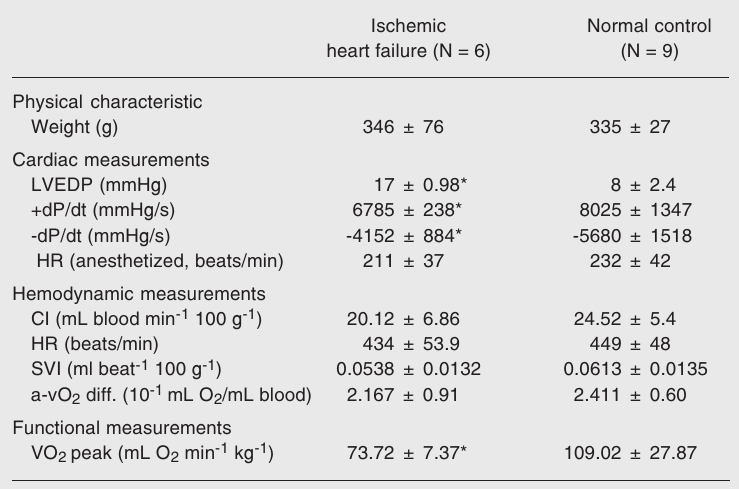
Table 1. Baseline cardiovascular parameters of rats with ischemic heart failure before treadmill exercise. Ischemic Normal control heart failure (N = 6) (N =